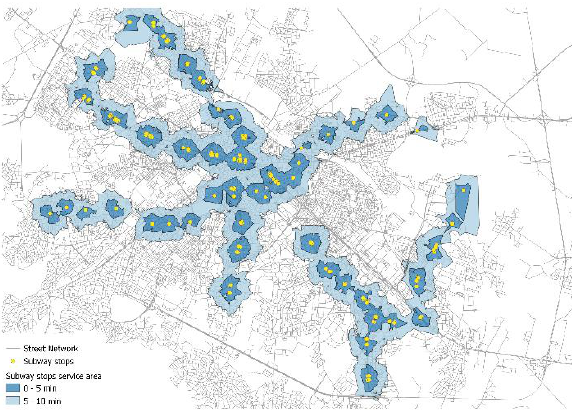
Figure 9. Comparison of accuracy of included buildings in the isochrone impedance in Buffer and Network Analysis for Ivan Vazov neighbourhood.